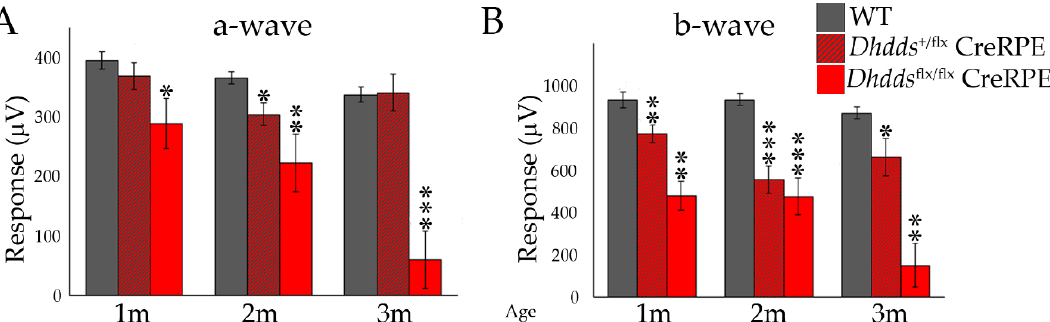
Figure 7. Scotopic ERG analysis of WT, Dhdds +/flx CreRPE , Dhdds flx/flx CreRPE mice. Maximum